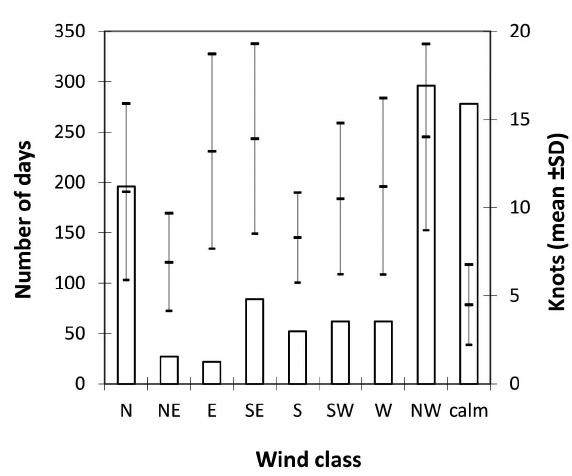
Fig. 5. – Bar graph reporting the wind statistics (number of days by wind classes) for the period May to June 1969-2005 used in the long-term analysis (years=36; valid years=25). Whiskers represents the wind speed variability in knots (mean ± SD). A prevalence of wind classes belonging to the 4 th quadrant (NW and N) is evident.